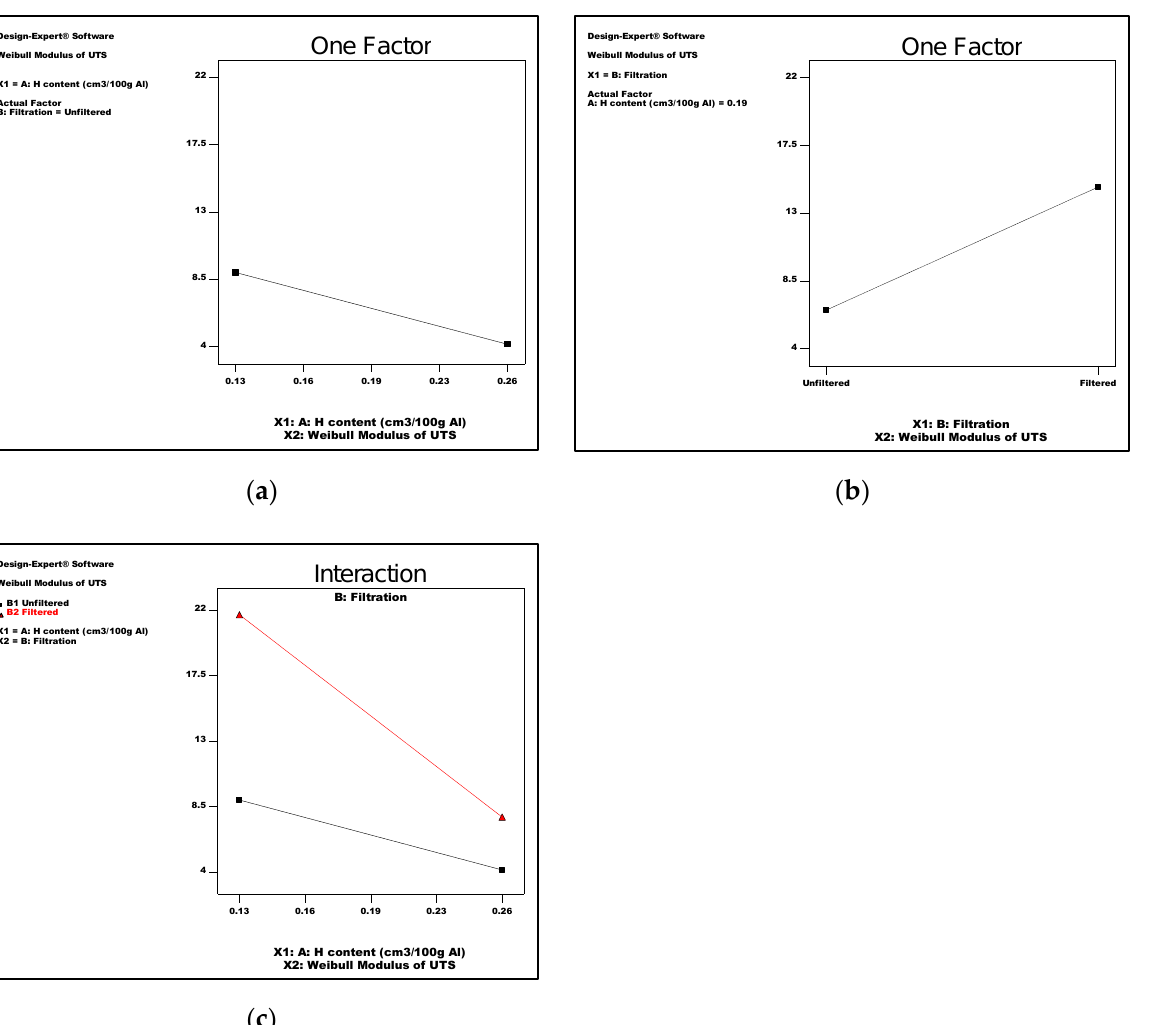
Figure 4. Effect of ( a ) hydrogen level, ( b ) use of filters, ( c ) the interaction between hydrogen level and filters on m UTS .